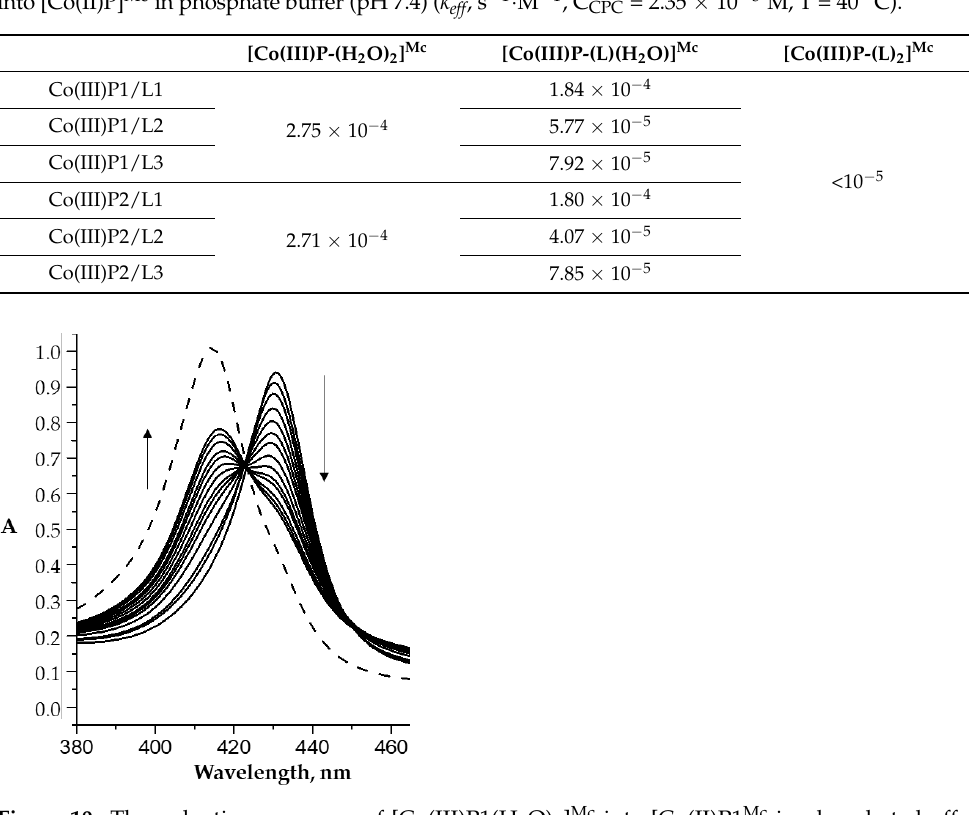
Table 5. Reduction rate constants of [Co(III)P-(H 2 O) 2 ] Mc , [Co(III)P-(L)(H 2 O)] Mc , and [Co(III)P-(L) 2 ] Mc